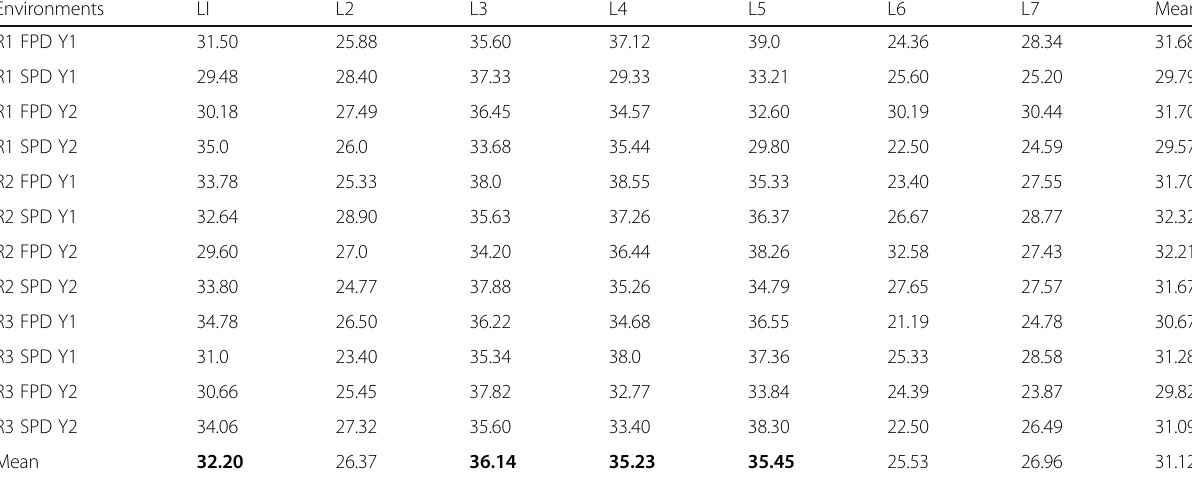
Table 6 The mean values for the seven rice entries under the 12 environments for 1000-grain weight Environments